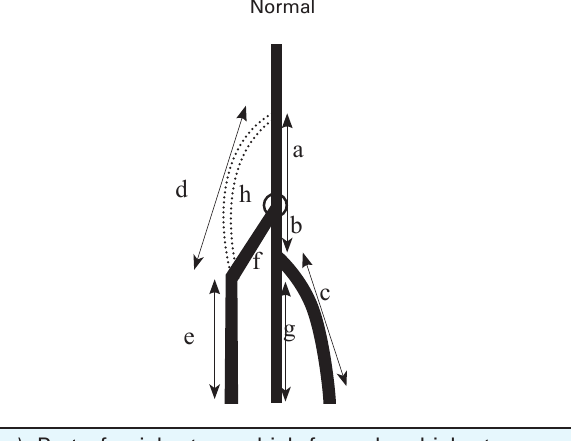
Figure 2.Ontogenic explanation of superficial